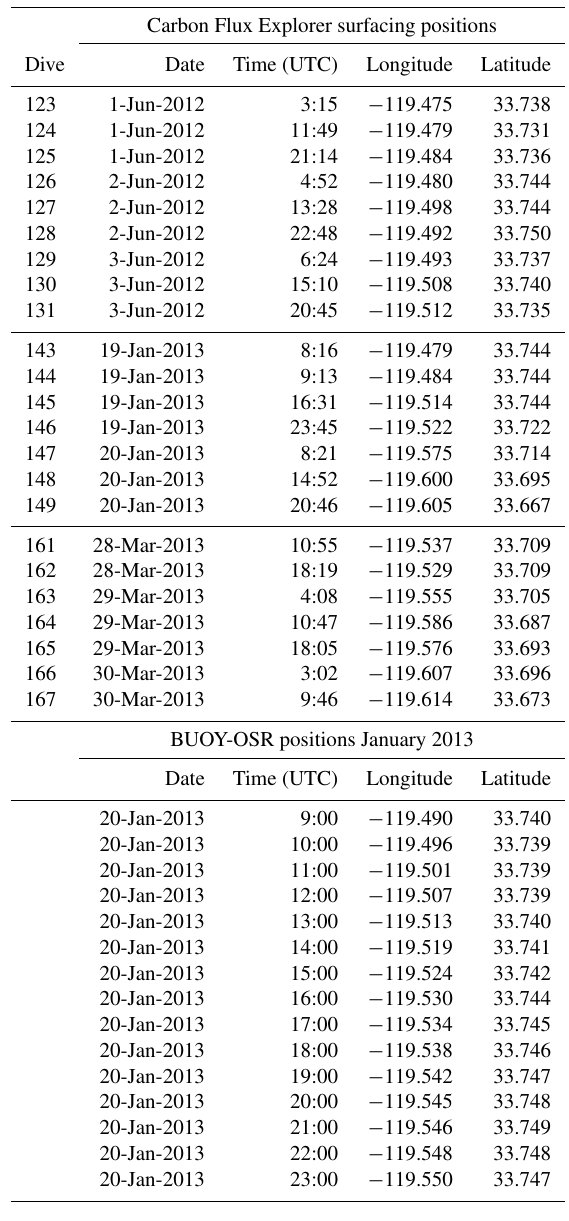
Table 1. Carbon Flux Explorer and BUOY-OSR